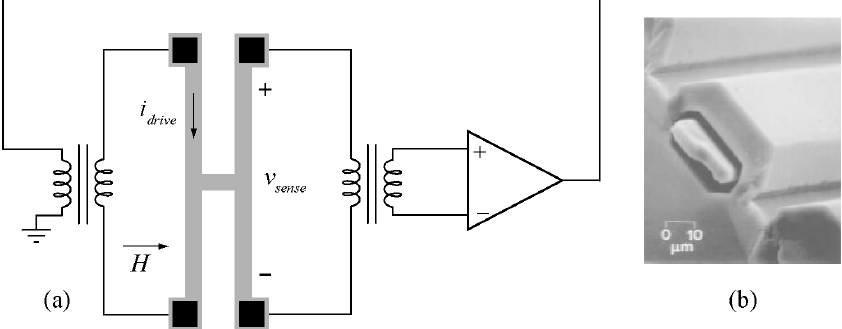
Figure 36. The resonant pressure sensor by Ikeda et al. [311]: ( a ) the schematic of the resonator and circuitry around it and ( b ) cross-sectional view of one of the beams inside the cavity and the encapsulation film. © 1998 IEEE. Reprinted with permission from Silicon Micromachined Vacuum Encapsulated Resonant Pressure Sensors by K. Ikeda in Proceedings of International Microprocesses and Nanotechnology Conference, 1998.